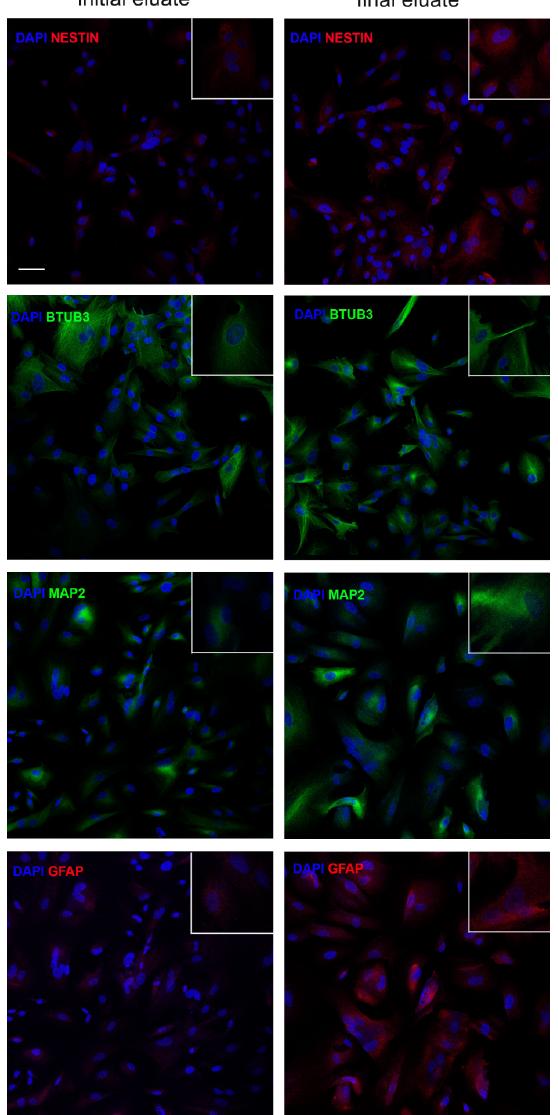
Figure 6. Evaluation of neurogenic differentiation potential of hAFSCs fractions. Differentiation capability of initial or final eluates into the neural lineage. Representative confocal images (and magnifications) of initial or final eluates of hAFSCs, exposed or not to neurogenic medium for 10 days, labelled with DAPI (blue), anti-nestin and anti-GFAP in red and anti- β 3-Tubulin (BTUB3) and MAP2 in green. Bar = 20 μ m.